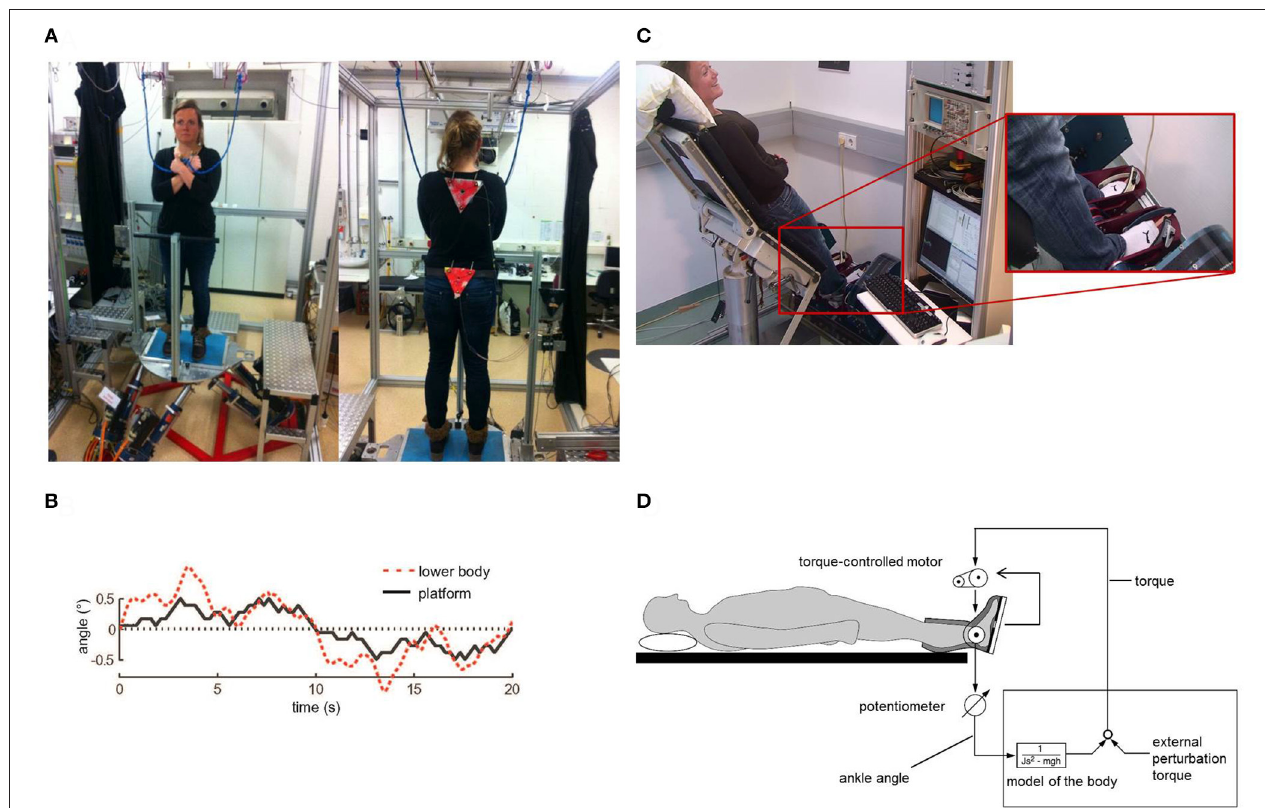
FIGURE 1 | Experimental setup. (A) Custom-built motion platform for measurements of spontaneous sway and perturbed stance. Angular excursions of the body and the platform were quantified with an optoelectronic camera system. (B) Example of a PRTS (pseudorandom ternary sequence) stimulus profile (black line) yielding to anterior-posterior rotational tilts of the platform with 1 ◦ peak-to-peak stimulus amplitude together with a healthy subject’s postural reaction in terms of lower body excursion (red dotted line). (C) Custom-made platform for virtual balancing. Subjects were lying in an inclined position with their feet positioned on a tilting balance board. They moved their feet in the ankle joint in order to control the balance board. (D) Potentiometers and torque sensors measured position as well as torque of the balance board with respect to the body. Measured board tilts were transferred online into board torque commands using the real time simulation toolbox of Simulink/Matlab, running on a PC. The ankle angle-to-torque transformation followed the characteristics of an inverted pendulum body, including virtual gravity (mgh), inertia (J) and damping. Board torque commands were fed back to the board via a torque controlled electric motor. External perturbations, i.e., PRTS stimuli, were applied as shifts of the zero equilibrium